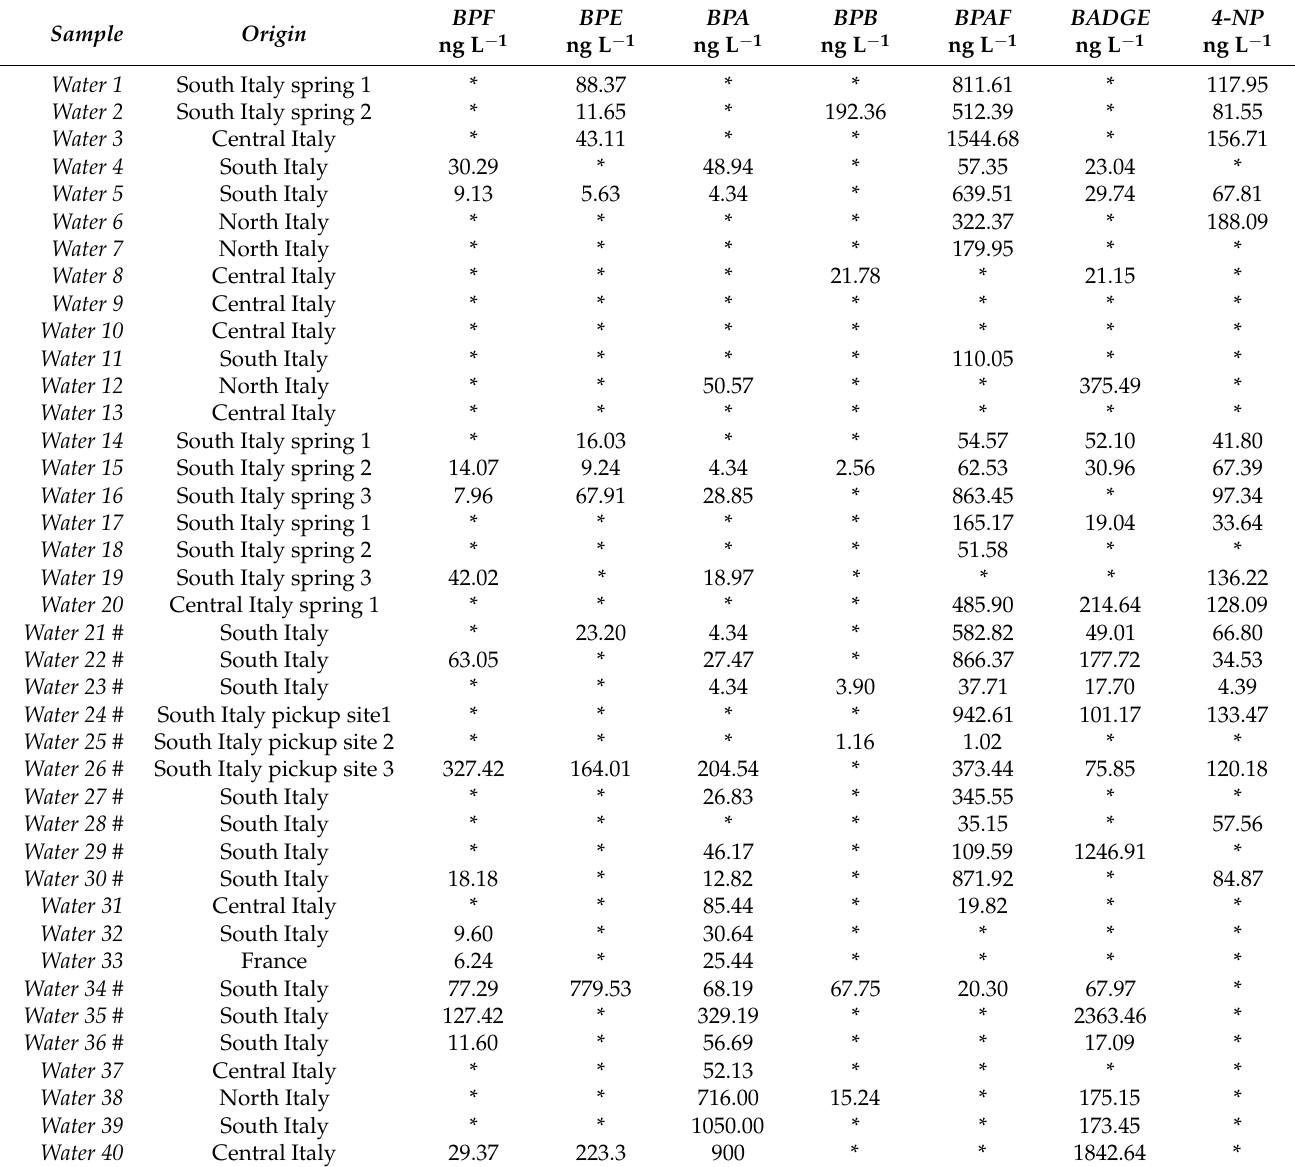
Table 1. FLD detected chemicals under investigation.